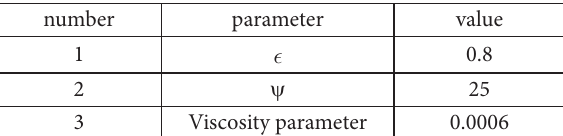
Table 3. Selected parameters which minimize the objective function in three-point notch beam